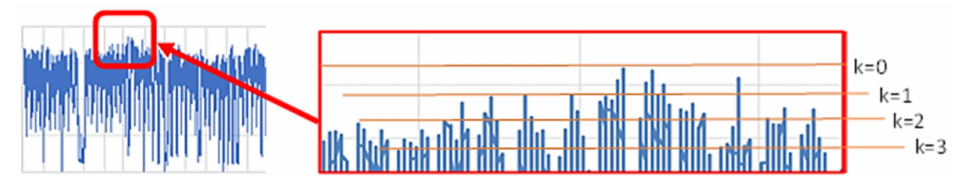
Figure 3. The effect of increasing the number of power exceedances while reducing the contractual power in the graph of the selected period of the average load power